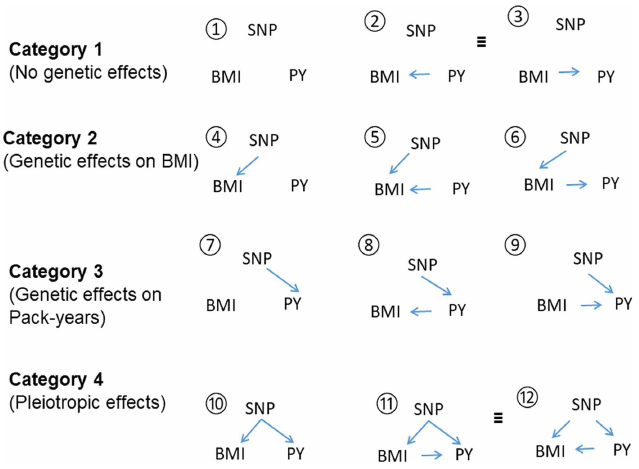
Fig 1. Twelve possbile directed acyclic graphs (DAGs) of one SNP, BMI and pack-years (PY) of smoking. PossibleDAGs betweenone SNP, BMI and PY. The DAGs are categorized into 4 groups. SNPs in Category1 (DAGs of 1, 2, and 3) do not have effects on either BMI or pack-years. SNPs in Category2 (DAGs of 4, 5, and 6) have direct effects on BMI, but not PY. SNPs in Category3 (DAGs of 7, 8, and 9) have direct effects on PY, but not BMI. SNPs in Category4 (DAGs of 10, 11, and 12) have pleiotropiceffects on BMI and PY. (cid:17) represents models that are not differentiable.